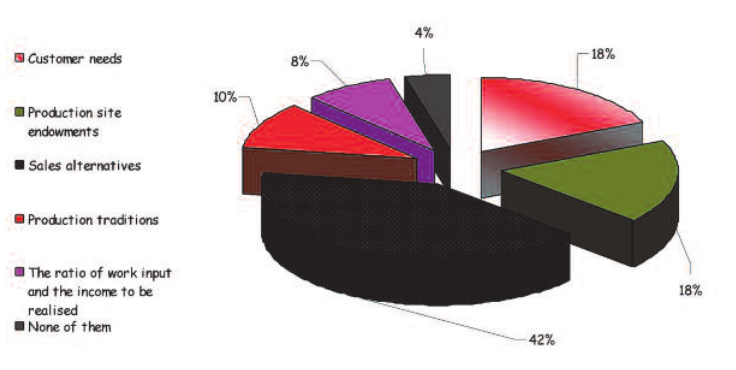
Figure 3. Distribution of determinate of used nectarin species, in the distribution (%) of valid answers, 2009 Source: On the basis of empirical research,